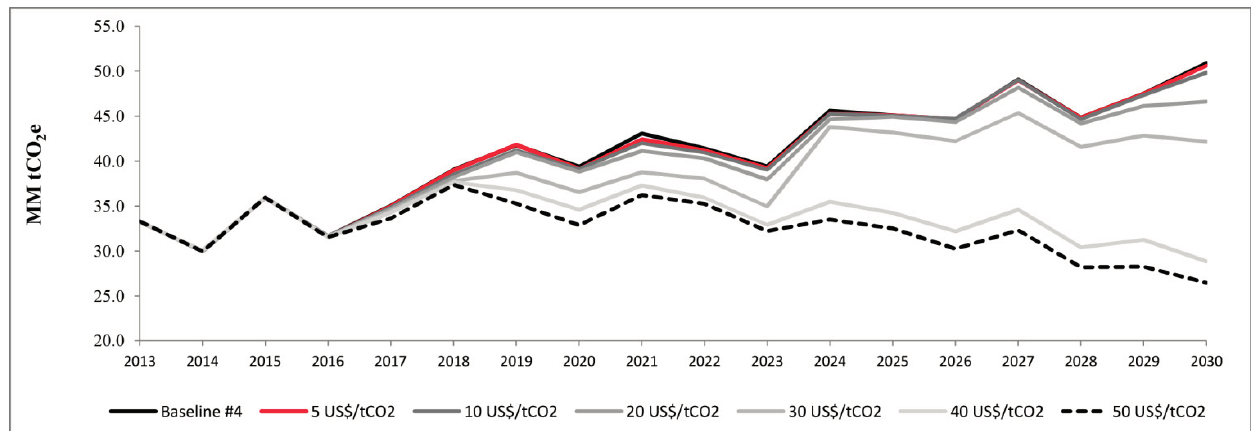
Figure 9. Emissions for baseline scenario #3 in comparison to different scenarios of carbon tax (MM = million).